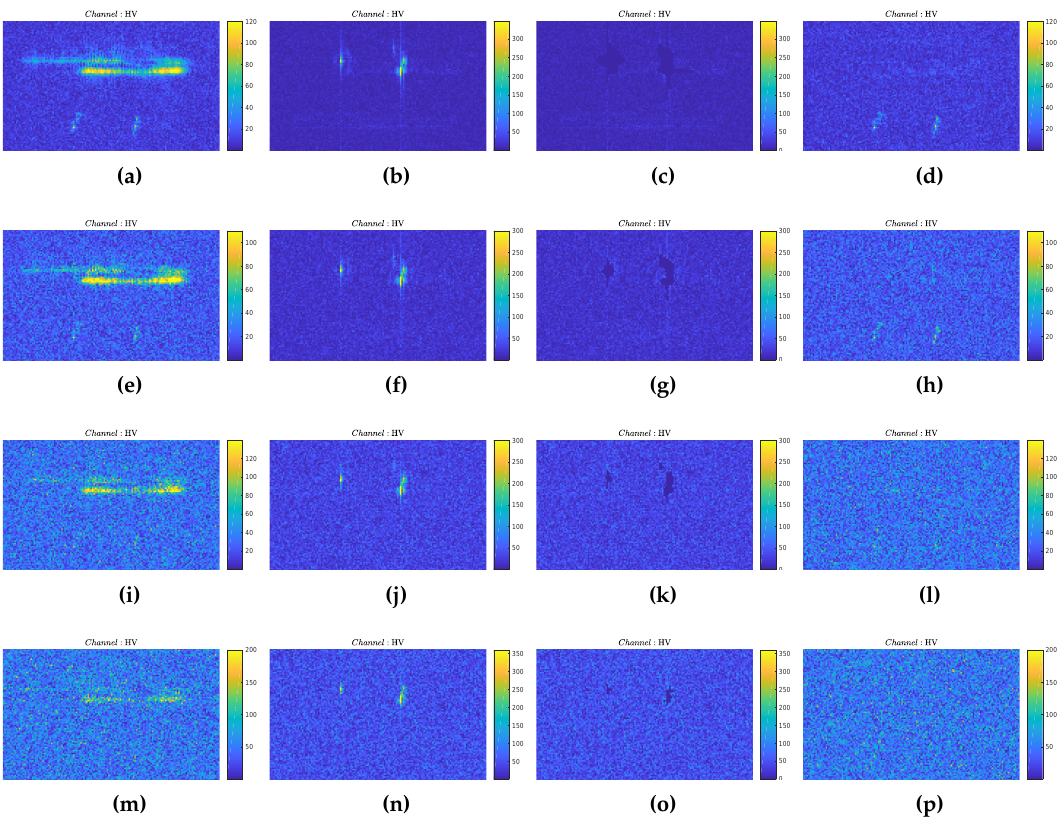
Figure 8. Simulations of the acquired HV polarized images with azimuth ambiguities of strong HH polarization based on parameters in Table 1 under SNRs of 20 dB (first row), 15 dB (second row), 10 dB (third row) and 6 dB (fourth row). The selected HV polarized images are separated from the original images in Figures 5 and 6, retaining the selected target area marked with red rectangles. Figures of ( a , e , i , m ) in the first column represent the focused HV images contaminated by HH ambiguities; the ambiguities of HH polarization are focused in figures of ( b , f , j , n ) in the second column, and then suppressed in ( c , g , k , o ) in the third column; through inverse-imaging, the final results are displayed in the fourth